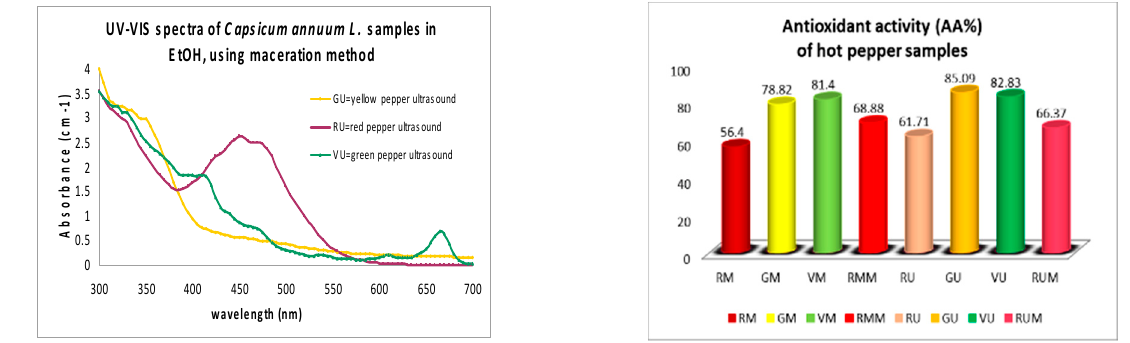
Figure 1. UV-VIS spectrum of Capsicum annuum L. and graph of the antioxidant activities (AA %) values for hot pepper